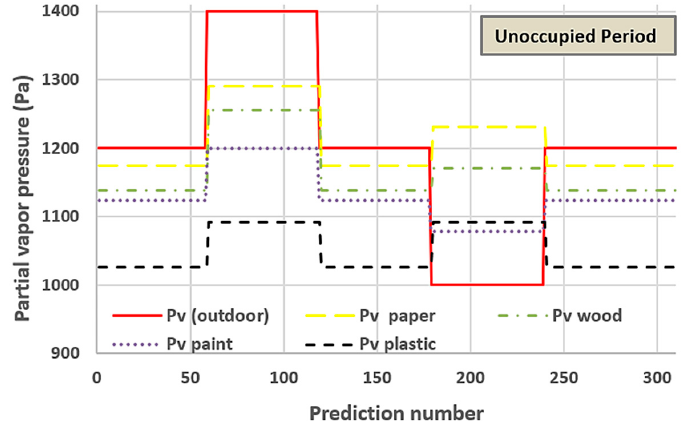
Figure 7. Artificial neural networks (ANNs) prediction of indoor and outdoor partial vapour pressure during the unoccupied period.